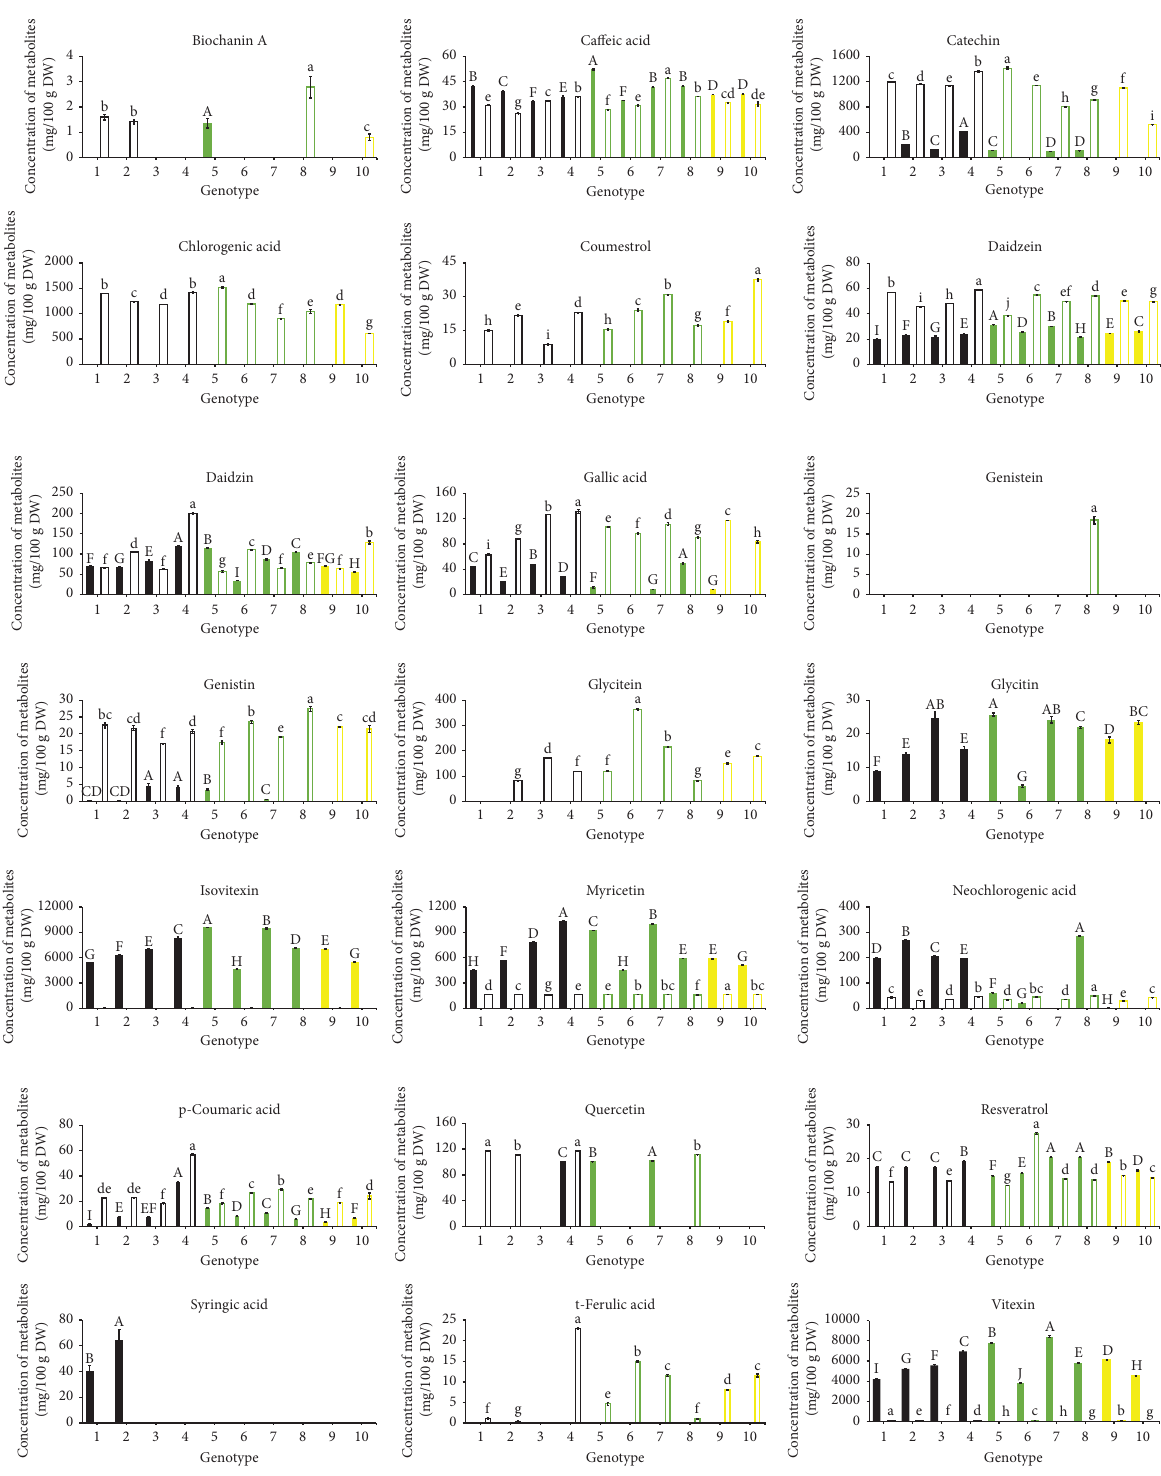
Figure 5: Metabolomic analysis of mungbean sprouts and seed coats. X and y axes indicate genotype and concentration of metabolites (mg/100 g DW), respectively. Capital and lowercase letters indicate signifcant diferences among whole sprouts and the seed coat, re- spectively. Te solid bar represents the seed coat, and the empty bar represents the whole sprout. Statistical analysis was conducted with a post hoc Duncan test ( p < 0 .